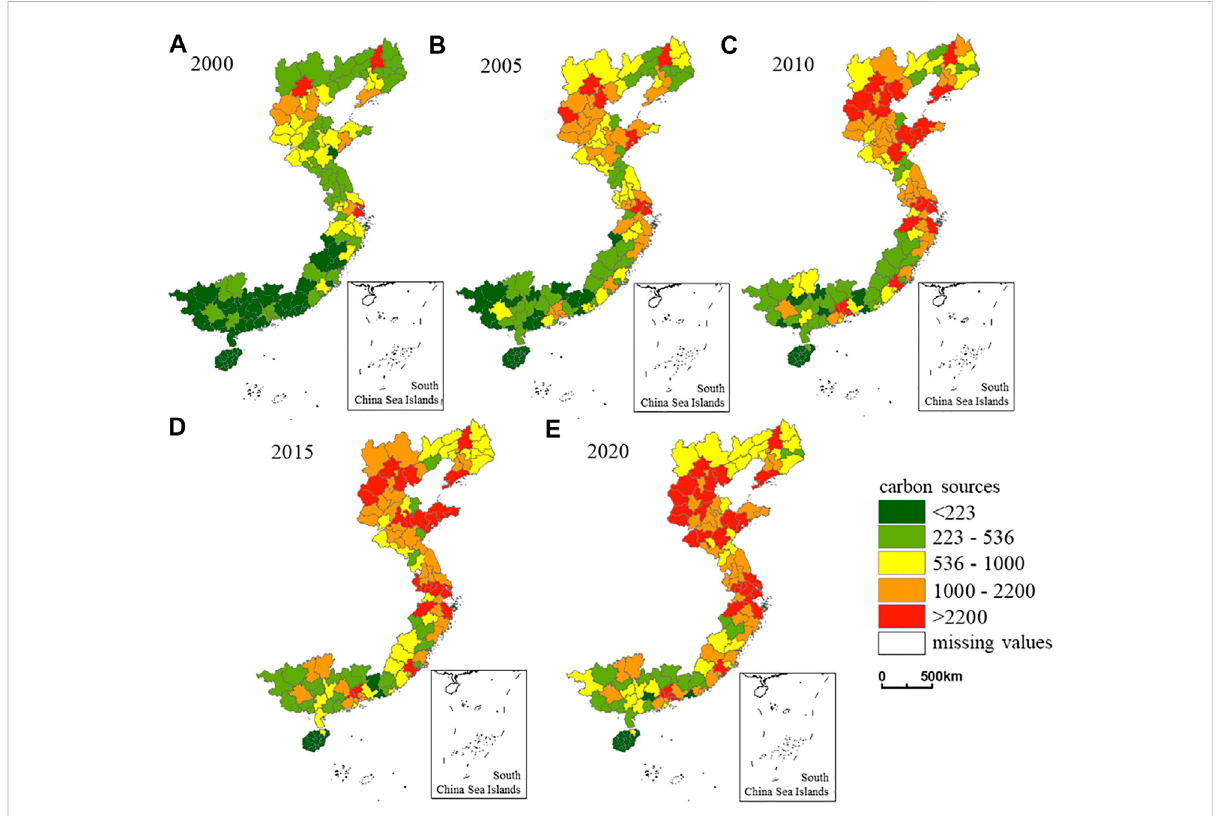
FIGURE 4 Spatial and temporal distribution of carbon sources from 2000 to 2020 (million